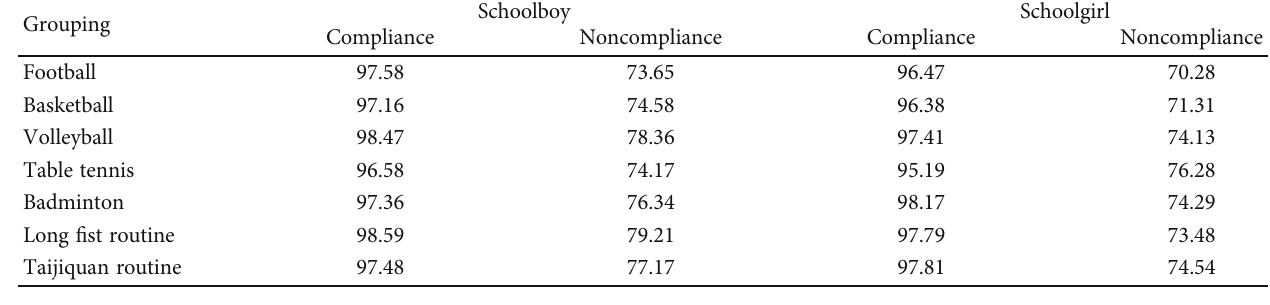
Table 2: Comparison of physical fi tness test compliance rates of students in di ff erent groups.